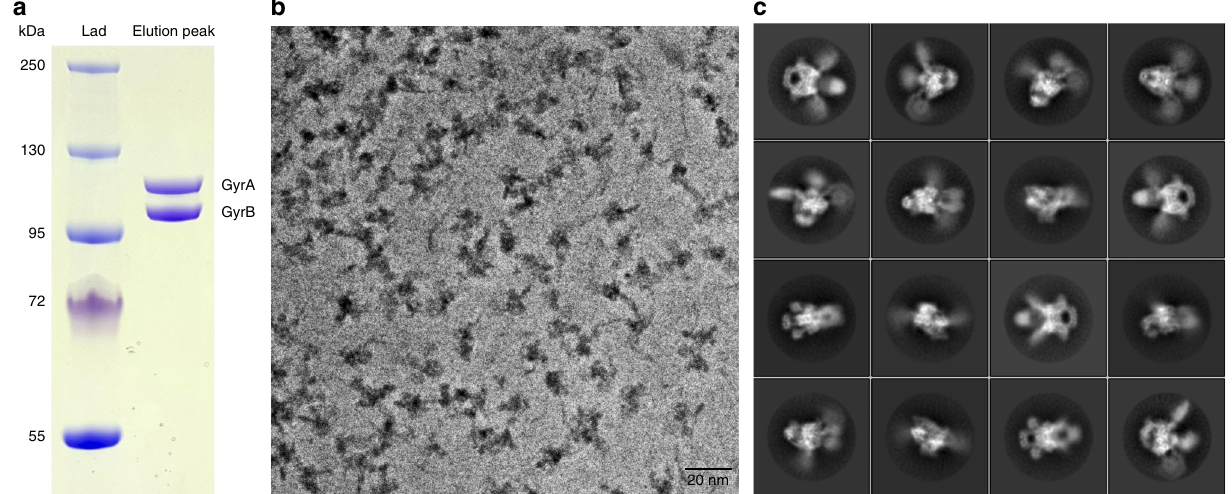
Fig. 1 Sample preparation and image acquisition. a SDS-PAGE analysis of the reconstituted GyrA 2 B 2 after size-exclusion chromatography. The source data are provided as a Source Data fi le. b A typical cryo-EM micrograph collected with a Gatan K2 Summit camera on a FEI Titan Krios microscope operated at 300 kV with Volta Phase Plate. The length of the scale bar is 20 nm. c Selection of 2D classes from reference-free 2D classi fi